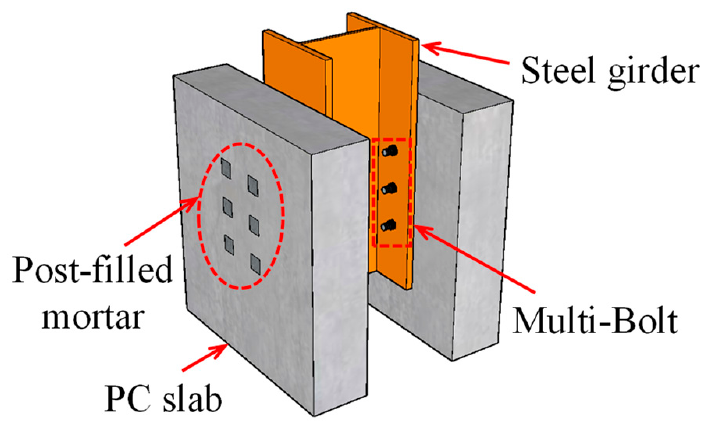
Figure 1. Schematic diagram of the push-out specimen (e.g., TS4).